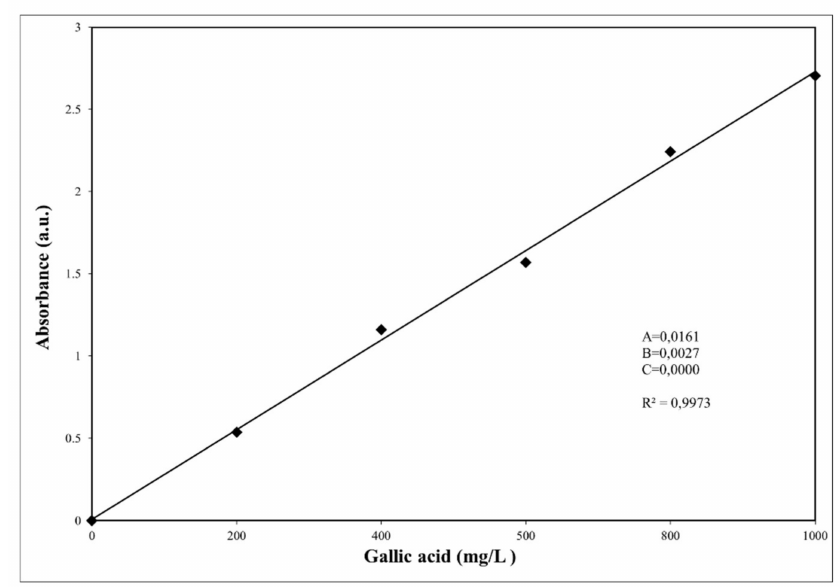
Figure 2. Folin–Ciocalteu Gallic Acid Standard